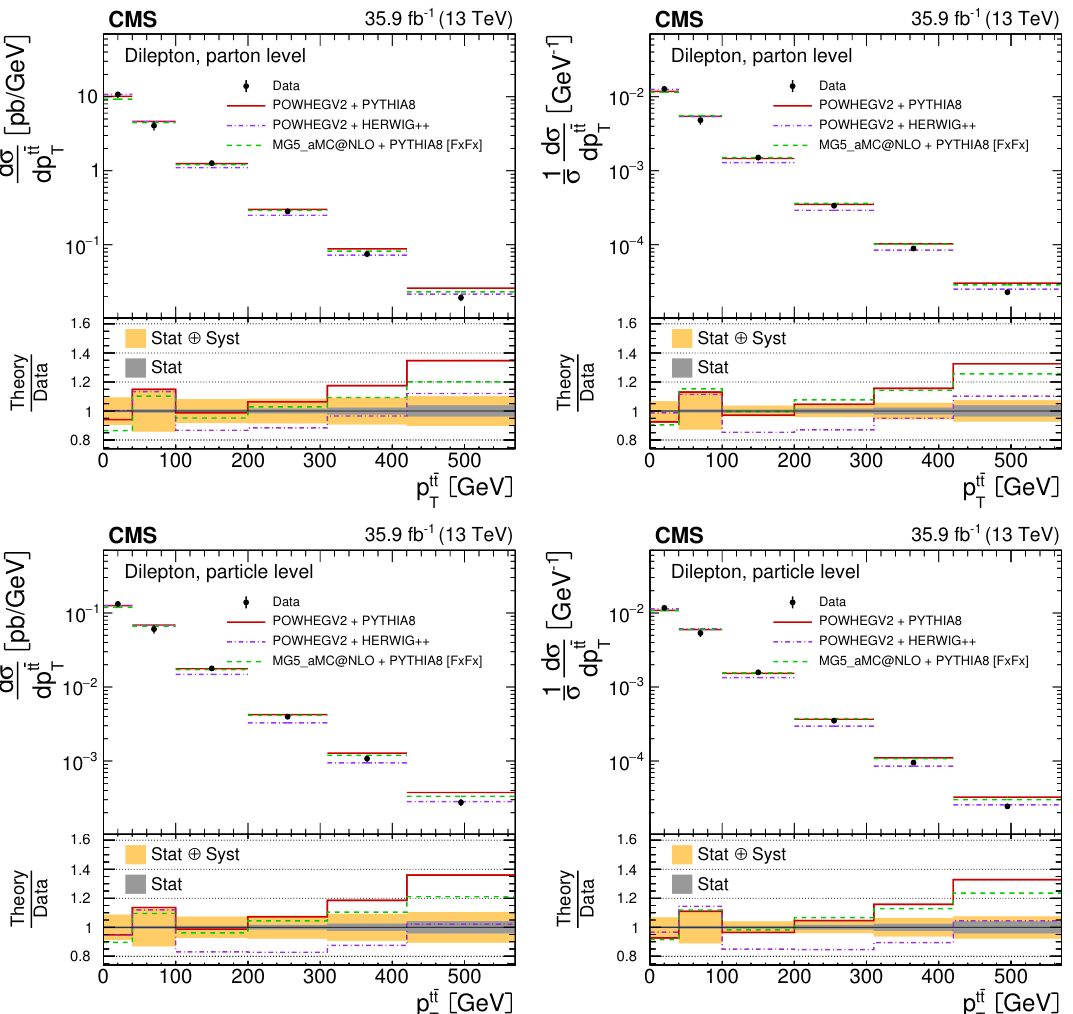
Figure 24 . The di(cid:11)erential tt production cross sections as a function of p tt data (points) and the MC predictions (lines). The vertical lines on the points indicate the total uncertainty in the data. The left and right columns correspond to absolute and normalised mea- surements, respectively. The upper row corresponds to measurements at the parton level in the full phase space and the lower row to the particle level in a (cid:12)ducial phase space. The lower panel in each plot shows the ratios of the theoretical predictions to the data. The dark and light bands show the relative statistical and total uncertainties in the data, respectively.